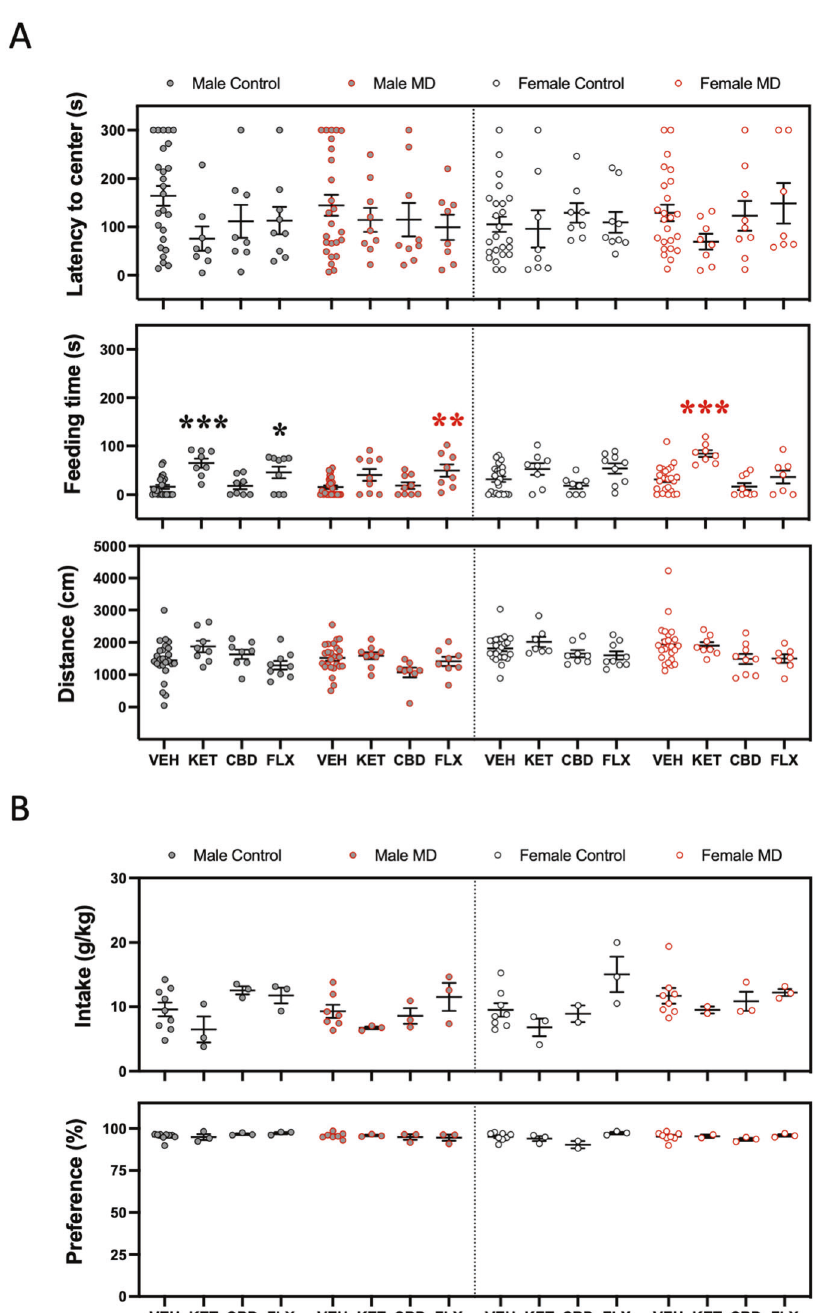
Fig. 3 Antidepressant-like effects as measured in the novelty-suppressed feeding test (NSF) or sucrose preference test (SP) during adolescence. A Repeated effects (3 days post-treatment) exerted by adolescent ketamine, cannabidiol, or fl uoxetine exposure in male and female rats (Control or MD) in the NSF. Data represent mean ± SEM of the latency to center (s), feeding time (s), or distance traveled (cm). B Repeated effects (6 – 7 days post-treatment) exerted by adolescent ketamine, cannabidiol, or fl uoxetine exposure in male and female rats (Control or MD) in the SP. Data represent mean ± SEM of the sucrose intake (g/kg) or preference (%). Individual values are shown for each rat (symbols). Three-way ANOVAs (independent variables: sex, early-life, and treatment) and two-way ANOVAs (independent variables: early-life and treatment) are shown in Supplementary Tables 1 and 2 respectively. *** p < 0.001, ** p < 0.01 and * p < 0.05 vs. the appropriate control group (Control or MD) and